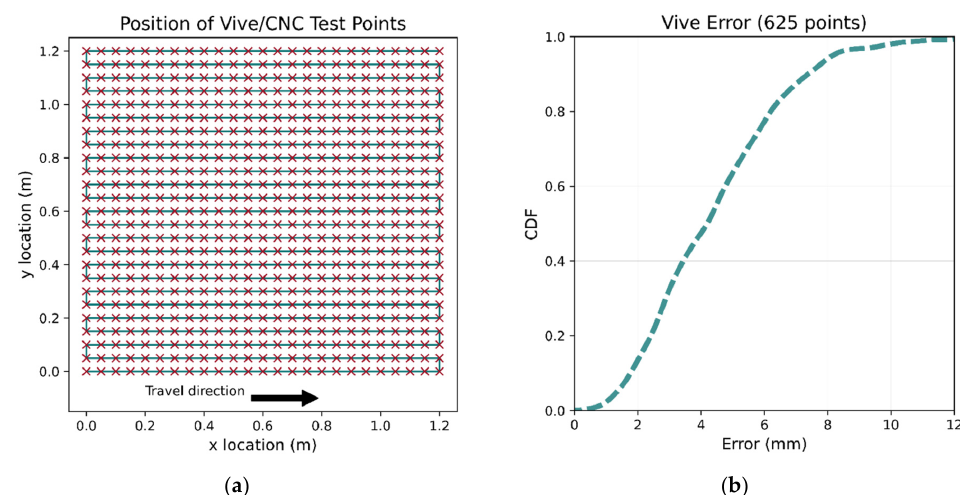
Figure 6. Determination of the Vive accuracy. The tracker was moved to 625 locations ( a ) by the CNC machine. The high accuracy of the CNC allows the Vive errors to be accurately calculated. The error CDF is shown in ( b ); median error is less than 4.5 mm. CDF is shown in ( b ); median error is less than 4.5